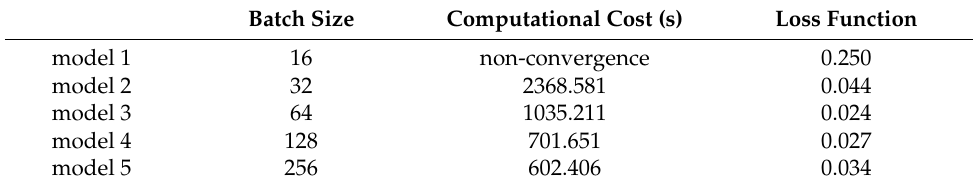
Table 5. Test results of different batch sizes.